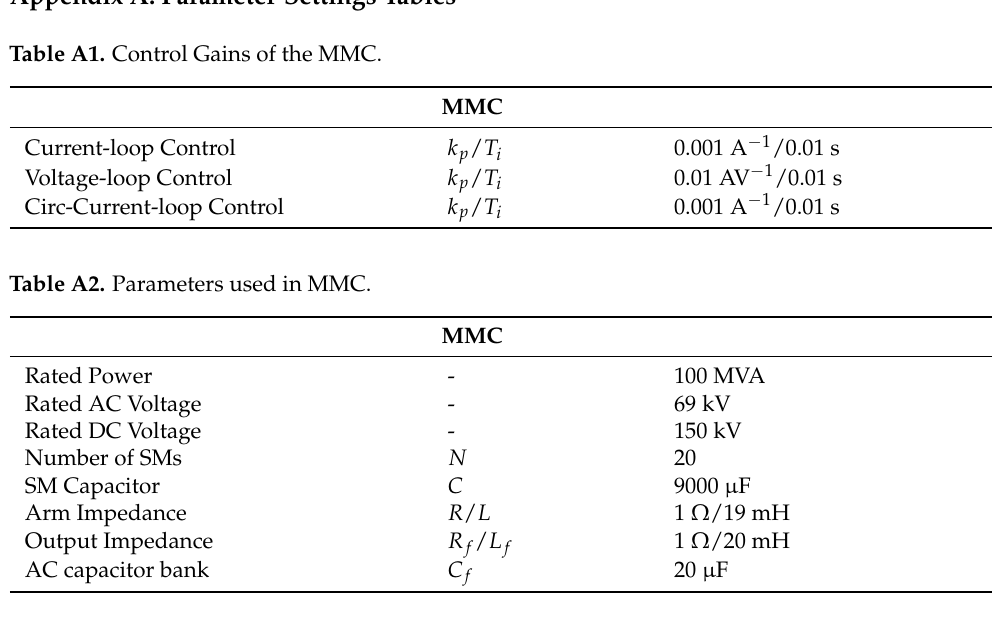
Table A3. Parameters used in the